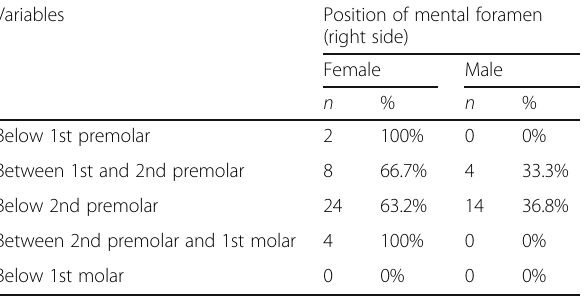
Table 2 Position of mental foramen in relation to gender and adjacent teeth on right side of mandible